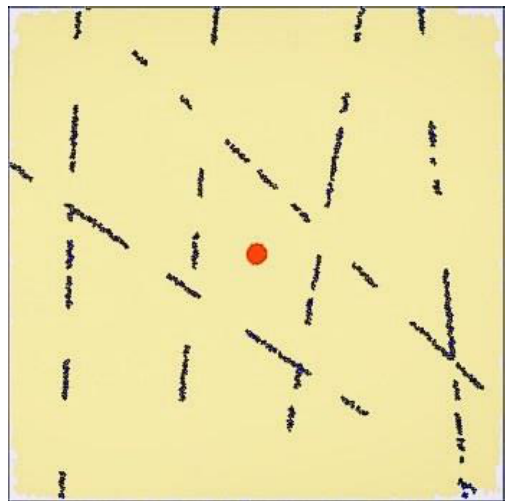
Figure 3. Particle flow numerical model of hydraulic fracturing. The yellow area represents the particles to be fractured; the black lines connecting the round particles represent the contact connection between the particles; the red region is the wellbore.